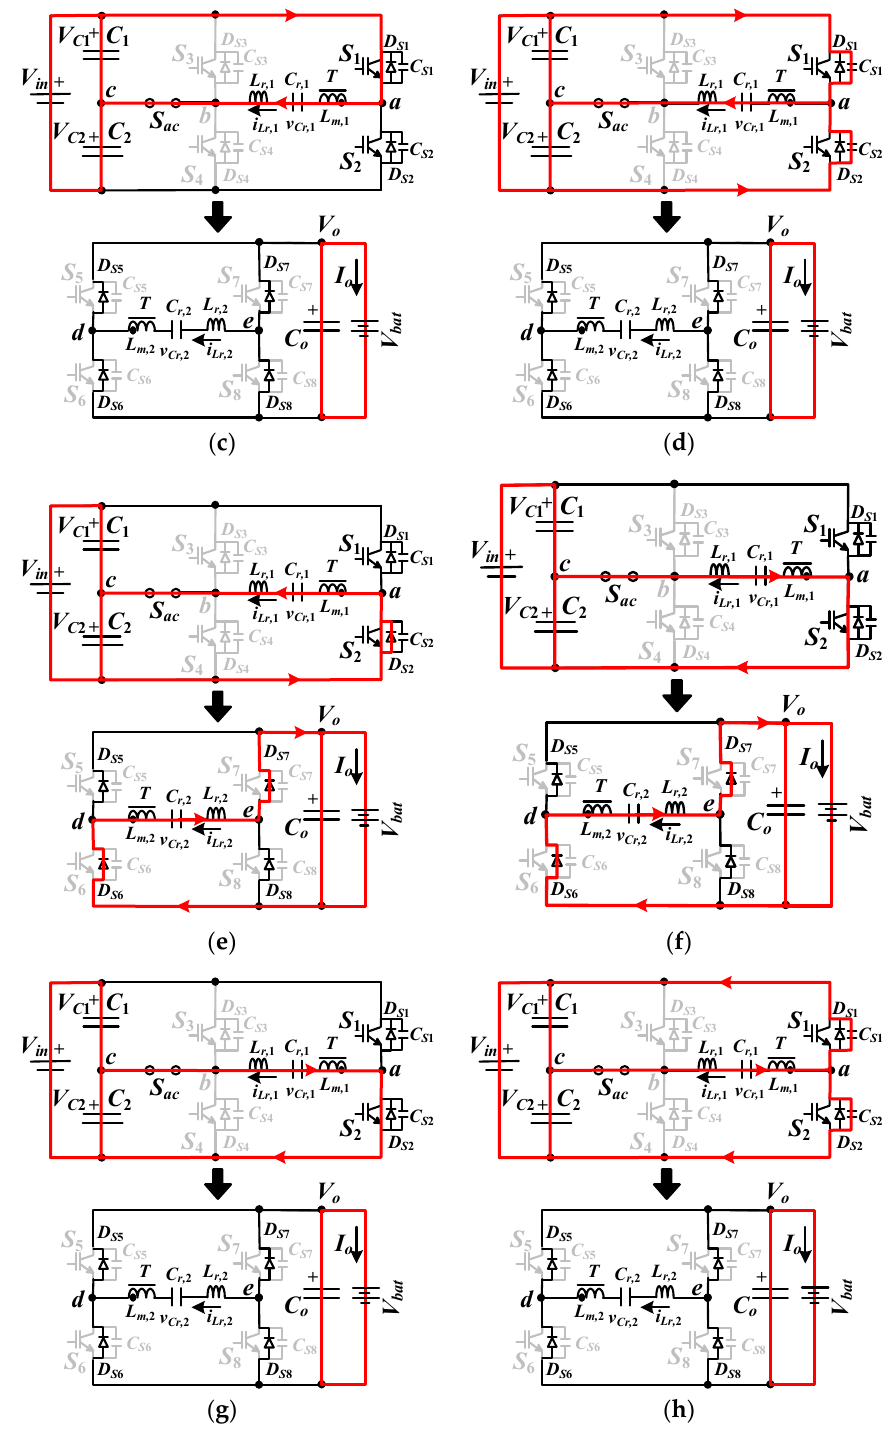
Figure 5. Equivalent circuits under low-output voltage range and forward power operation: ( a ) state 1; ( b ) state 2; ( c ) state 3; ( d ) state 4; ( e ) state 5; ( f ) state 6; ( g ) state 7; ( h ) state